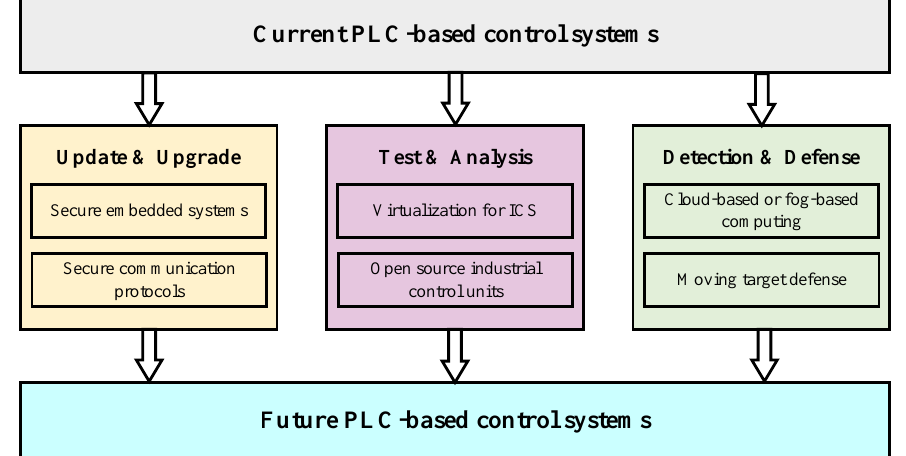
Figure 6. Relationship among each part of future